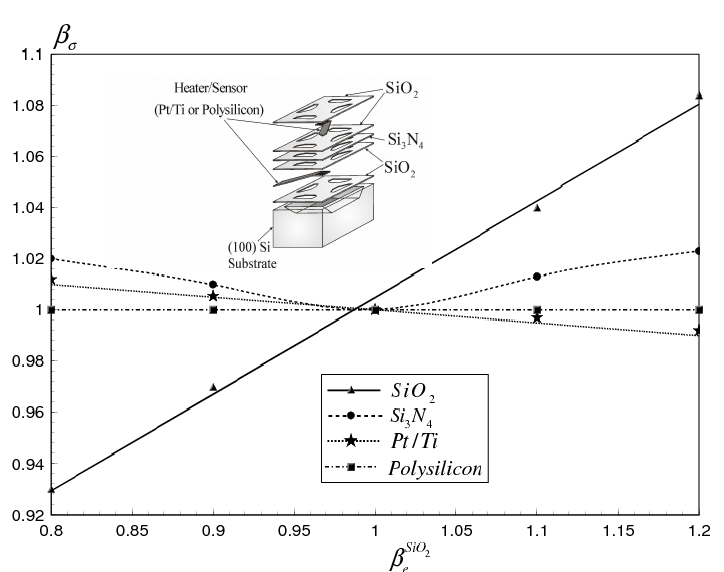
Figure 11. Effect of the variation of the coefficient of thermal expansion of SiO on the maximum thermal stress of different gas sensor